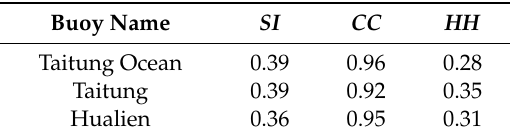
Table 3. Statistical parameters of SWH based on model-data comparison for di ff erent buoys using winds from ERA5_1hr_H1.